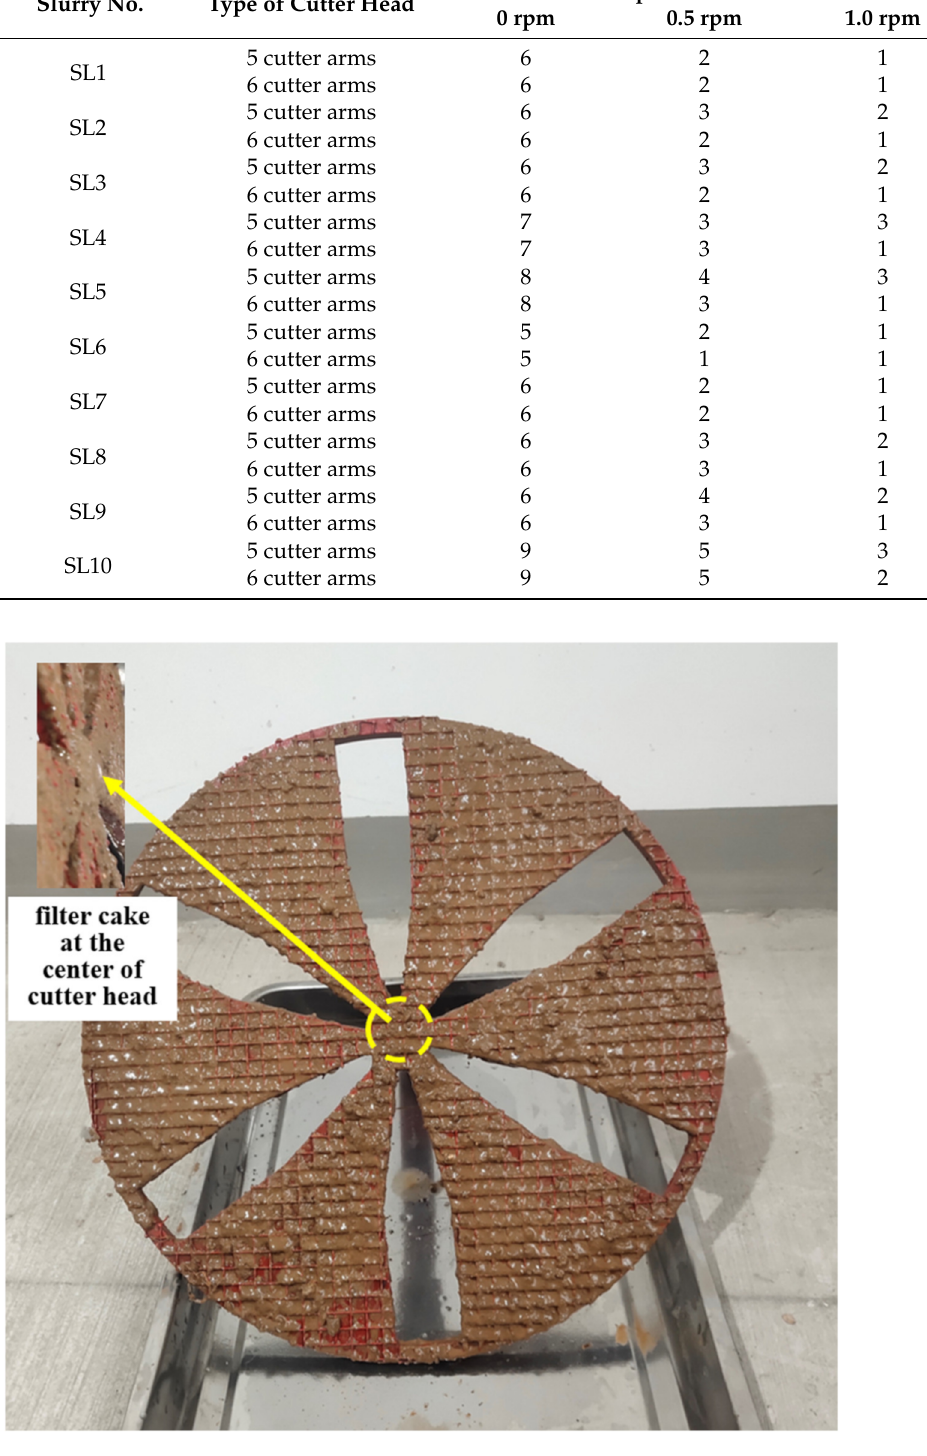
Figure 14. Filter cake attached to the cutter